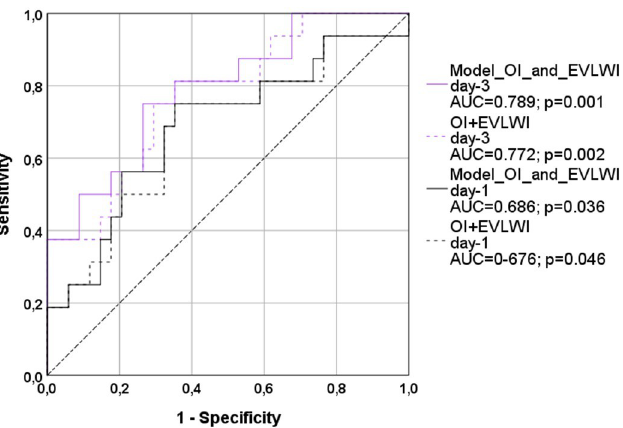
Fig 6. Validation-study (dataset (n=50) from reference [20]): ROC-AUC regarding mortality. The models OI_and_EVLWI were calculated from the regression formula derived from this study (evaluation study). OI: oxygenation index; EVLWI: Extra-vascular Lung Water Index. AUC: area under the curve.